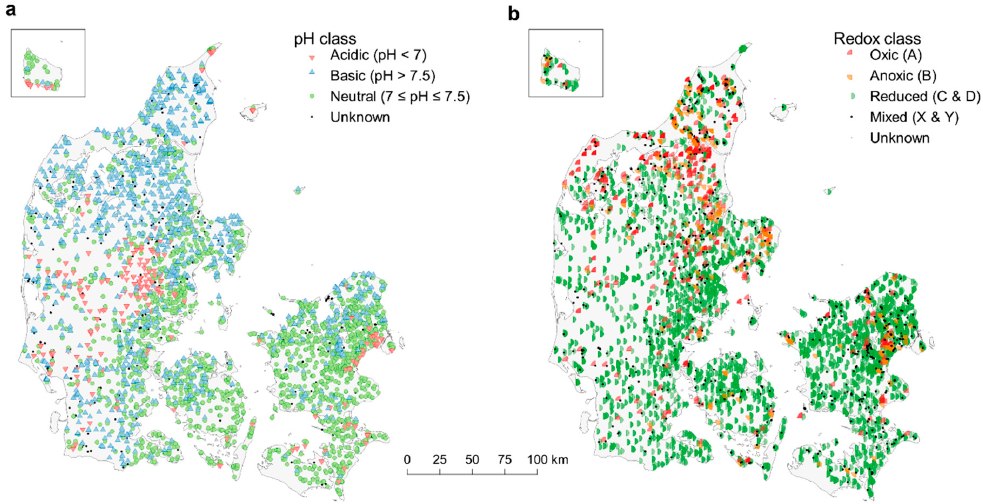
Figure 5. Spatial distribution of the groundwater sampling points based on their pH ( a ) and redox ( b ) class.